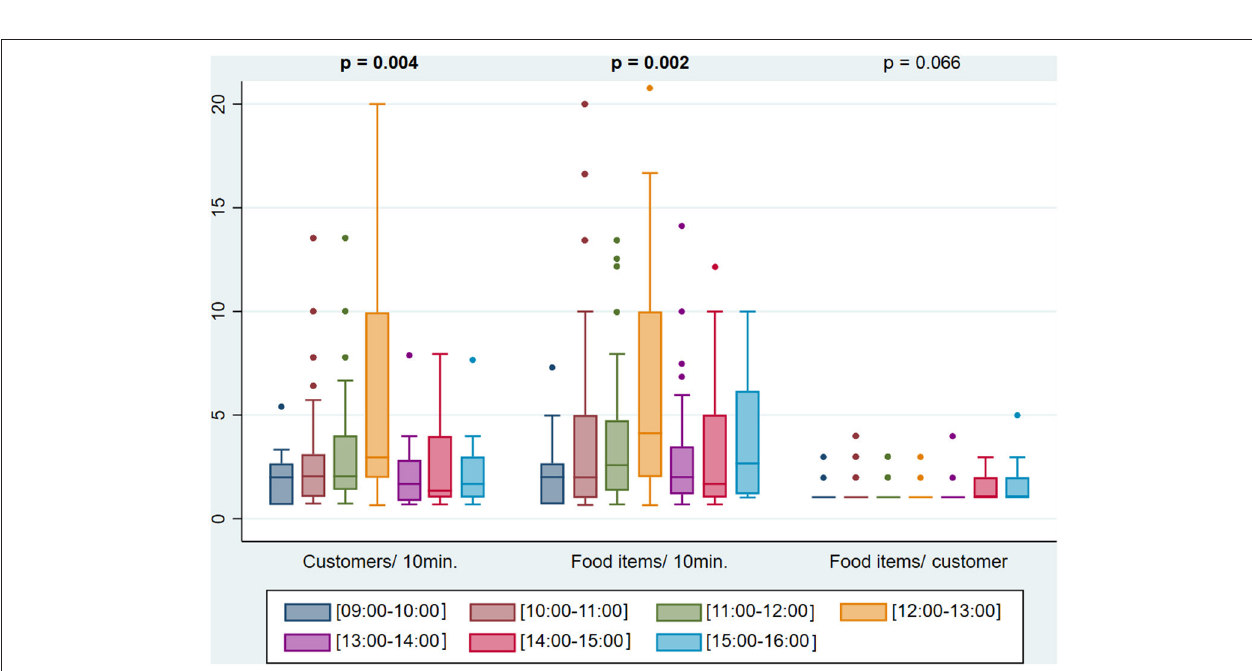
FIGURE 1 | Customers’ influx (customers/10min), food items buying rate (food items/10min) and number of food items purchased per customer (food items/ customer), in street food vending sites observed in Dushanbe (Tajikistan), Bishkek (Kyrgyzstan), Ashgabat (Turkmenistan) and Almaty (Kazakhstan). Values in bold represent statistically significant differences according to Kruskal–Wallis test with a significance level of